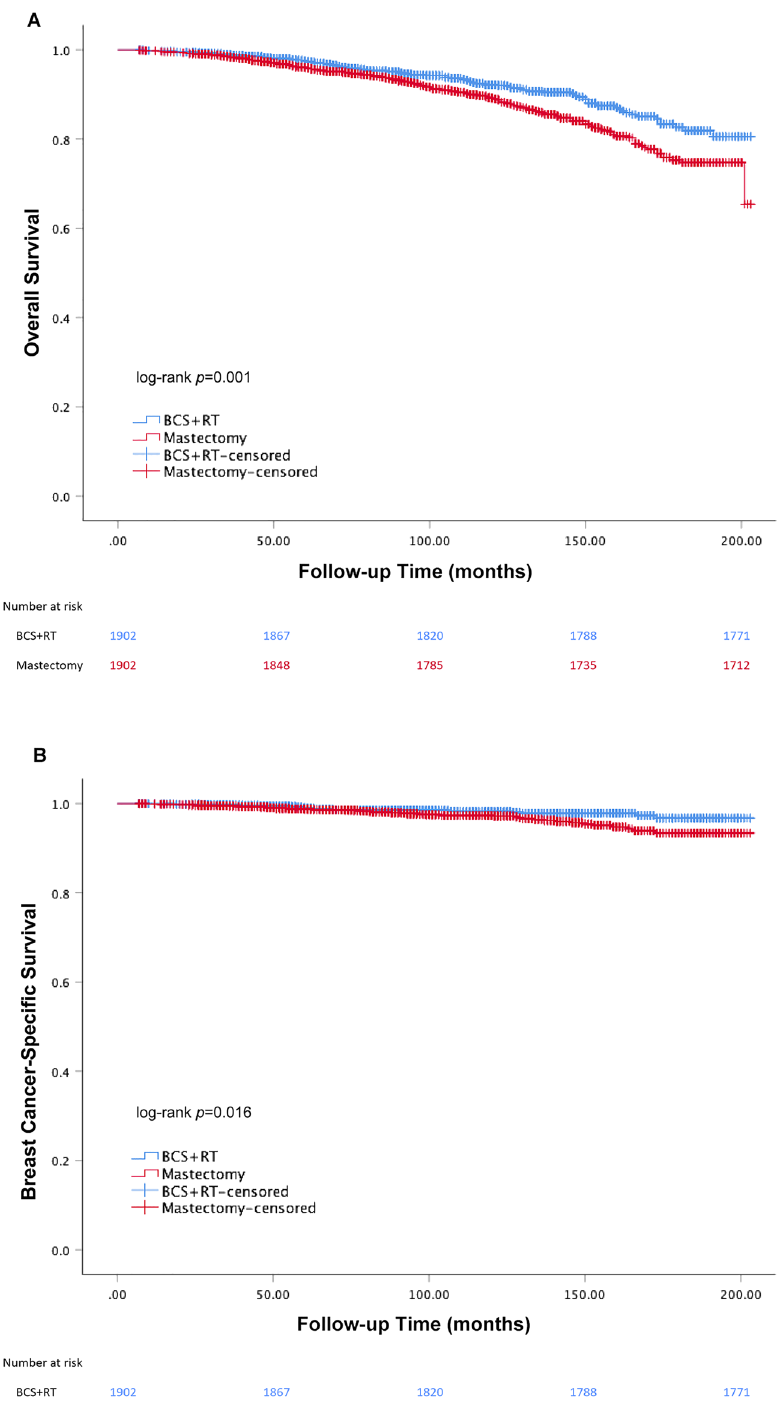
Figure 2. Kaplan–Meier curves of OS ( A ) and BCSS ( B ): propensity matched landmark